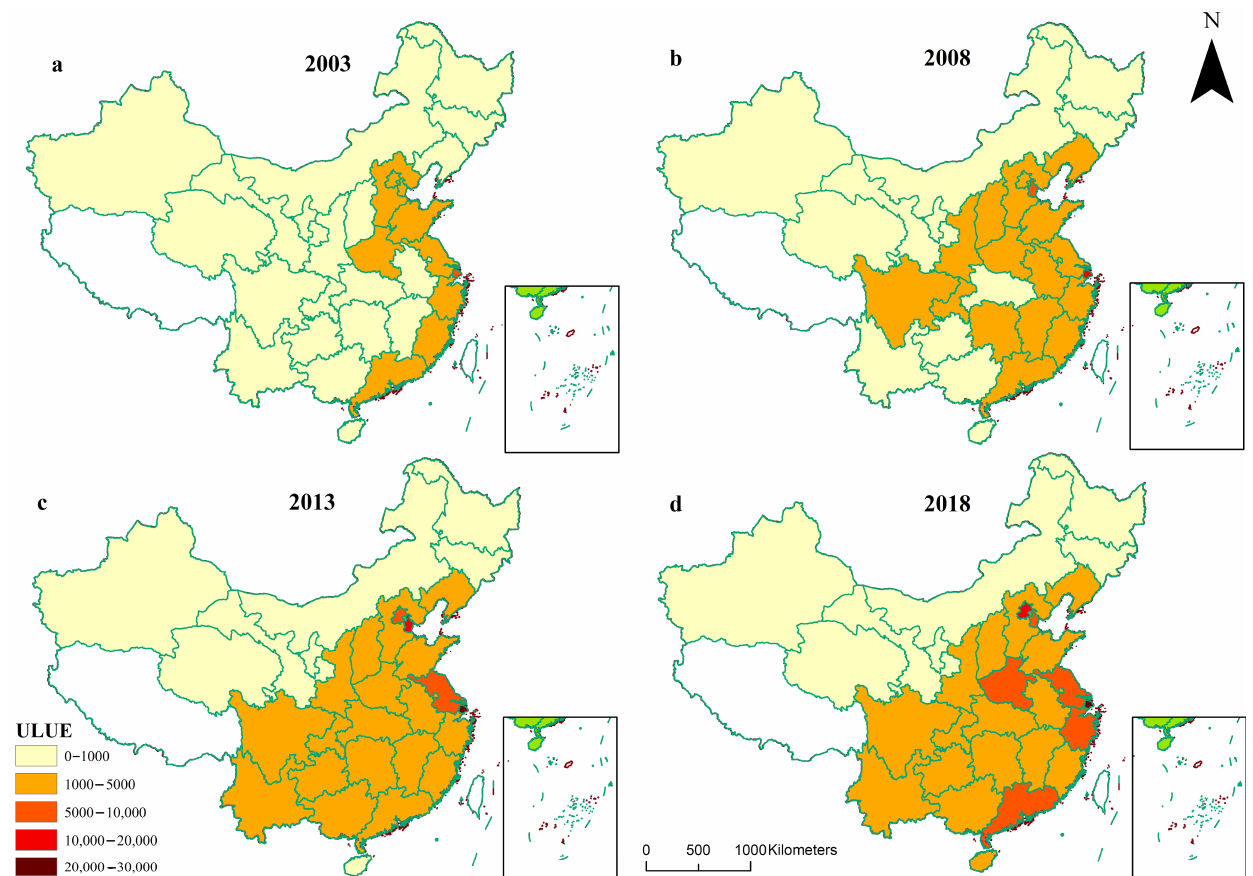
Figure 3. Temporal and spatial changes in ULUE. ( a ) ULUE in 2003; ( b ) ULUE in 2008; ( c ) ULUE in 2013; ( d ) ULUE in